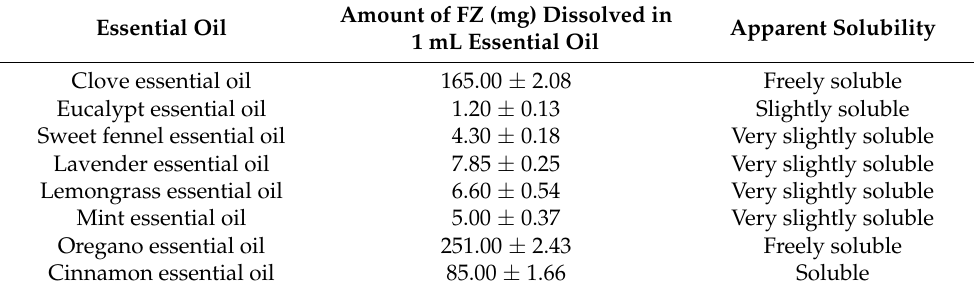
Table 3. Apparent solubility of fluconazole in the selected essential